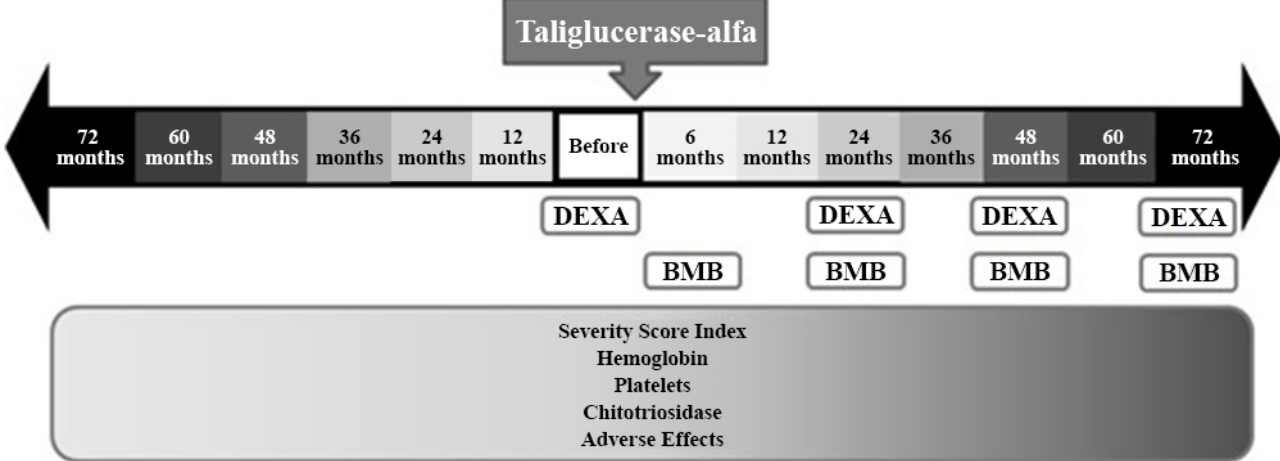
Figure 1. Schematic diagram of study protocol. DEXA was performed before ERT with taliglucerase alfa and every other year thereafter; MRI for BMB score was performed during the first year of treatment and every other year thereafter; Severity Score Index, hemoglobin, platelets, and chitotriosidase were assessed every 3 months; Adverse events were evaluated throughout the study period. BMD = bone mineral density; BMB = Bone Marrow Burden